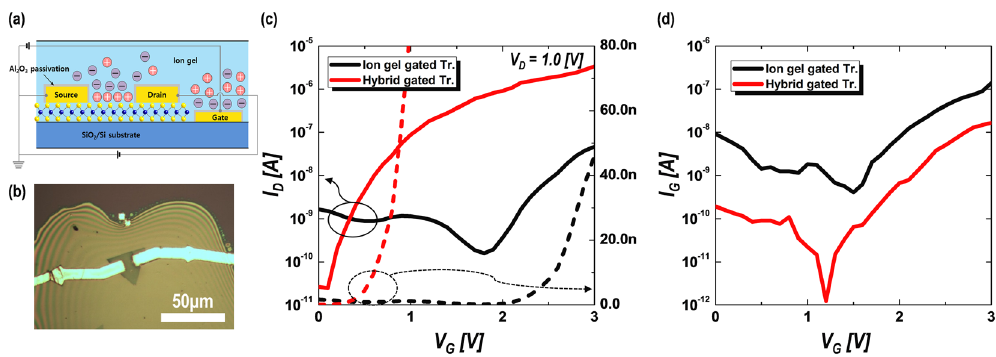
Figure 4. ( a ) Schematic and ( b ) optical micrograph of the hybrid-structure EDLTs fabricated using monolayer single-crystalline MoS 2 . ( c ) Transfer curve and ( d ) gate leakage current (absolute values) of the MoS 2 EDLTs without passivation (ion gel gated Tr.) and with 3-nm-thick Al 2 O 3 passivation layer (Hybrid gated Tr.) measured at drain voltage of 1.0 V under room temperature. Solid line and dashed line in transfer graph indicate the logarithmic-scale (left-side axis) and linear-scale (right-side axis) value of drain current,